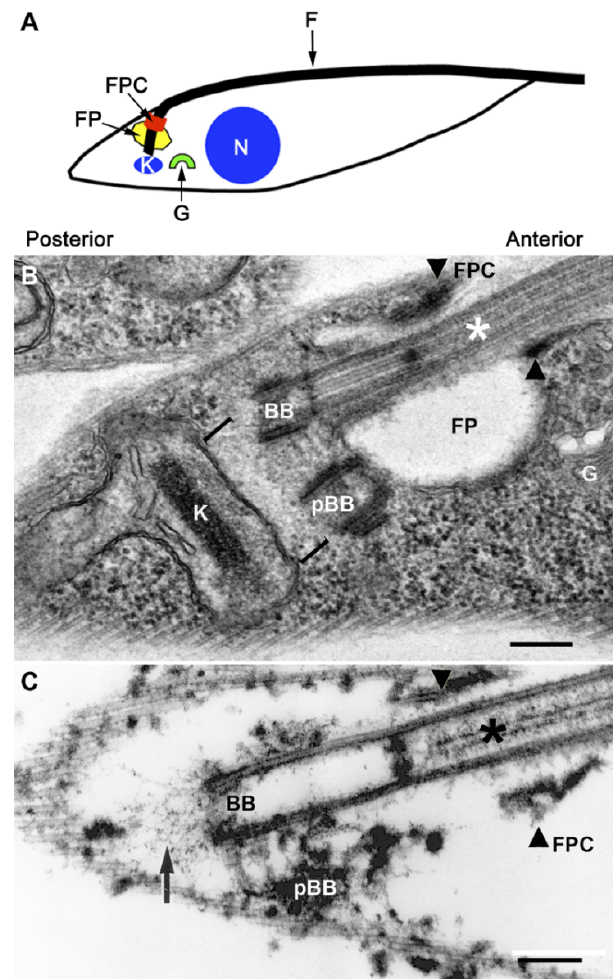
Figure 1. Schematic diagram of a T. brucei procyclic cell, showing cell polarity and organelle location. ( A ) The schematic shows the anterior and posterior regions of the cell. Note the polarization of organelles and structures to the cell posterior including the flagellar pocket (FP), flagellar pocket collar (FPC), Kinetoplast (K) and Golgi apparatus (G). (N), indicates the nucleus and (F) the flagellum. Figure 1A is reproduced from [44]; ( B ) Transmission electron micrograph of a thin section through the FP of a T. brucei procyclic cell. The asterisk indicates the axoneme. The mature basal body is denoted by BB . The immature basal body is denoted by pBB , and in this case it may have started maturing and has docked with the FP. The square brackets denote the ribosome free region. The kinetoplast ( K ) is the mitochondrial genome. The flagellar pocket is denoted by FP and the FPC is marked by arrowheads. The Golgi apparatus is denoted by G . The FPC forms the adherens-like junction containing BILBO1; ( C ) A thin section transmission electron micrograph similar to ( A ), but from a T. brucei procyclic “cytoskeleton”, where the soluble cell contents and membranes have been extracted with non-ionic detergent. The labels are the same as in (B) except the addition of the black arrow, which indicates the exclusion zone filaments of the tripartite attachment complex (TAC) [45]. Scale bars: 250 nm.